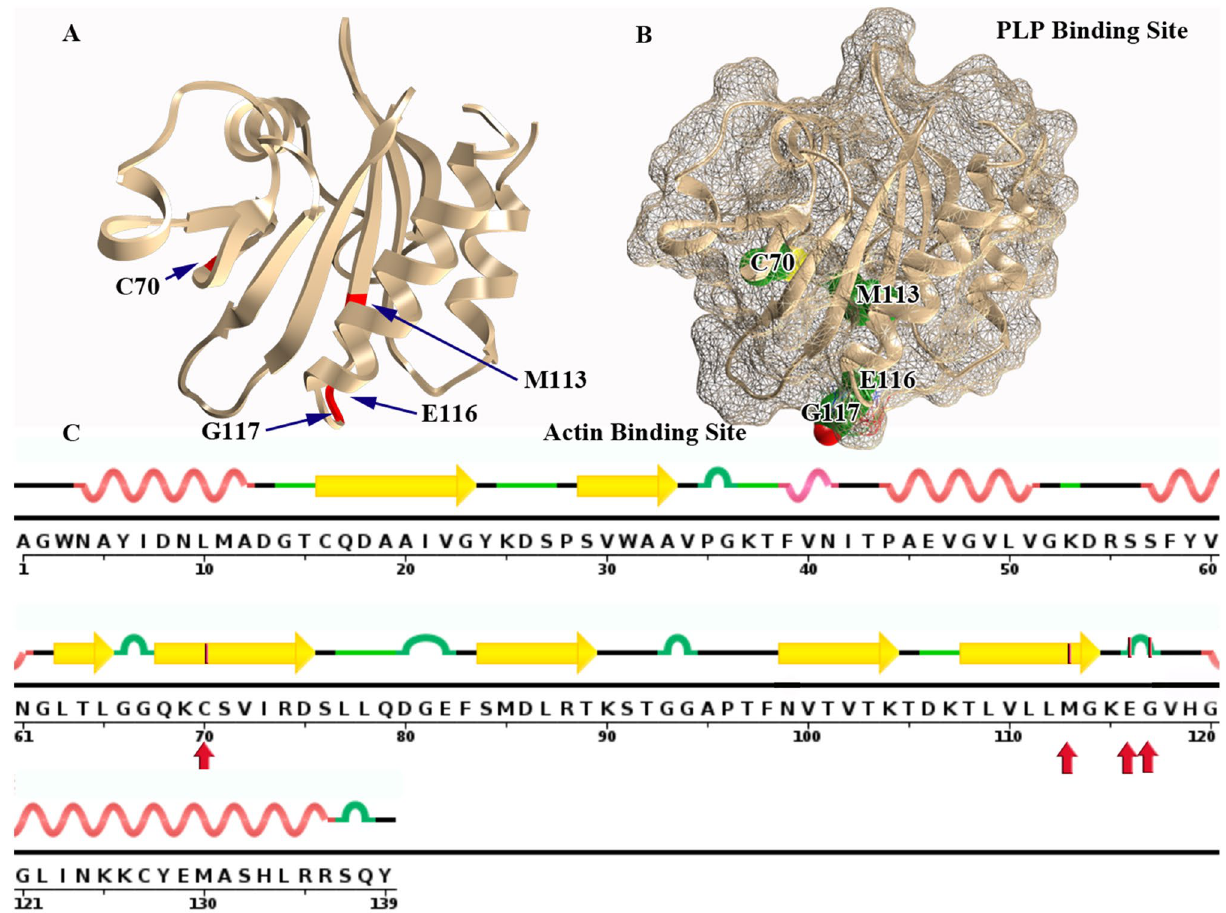
Figure 4. The position of the mutated 4 amino acids in PFN-1 associated with pathogenic injuries in ALS. ( A ) Ribbon view showing the location of the reported mutated 4 amino acids. ( B ) Surface views of the structure and sphere views of the actin-binding domain showing the amino acids E116, G117 located on the surface. Amino acids C70 and M113 are located deep inside the structure. ( C ) Secondary structure of the protein sequence and the position of the mutated amino acids in the polypeptide chain. The C70 and M113 are located on the beta- strand domain and E116 and G117 are on the